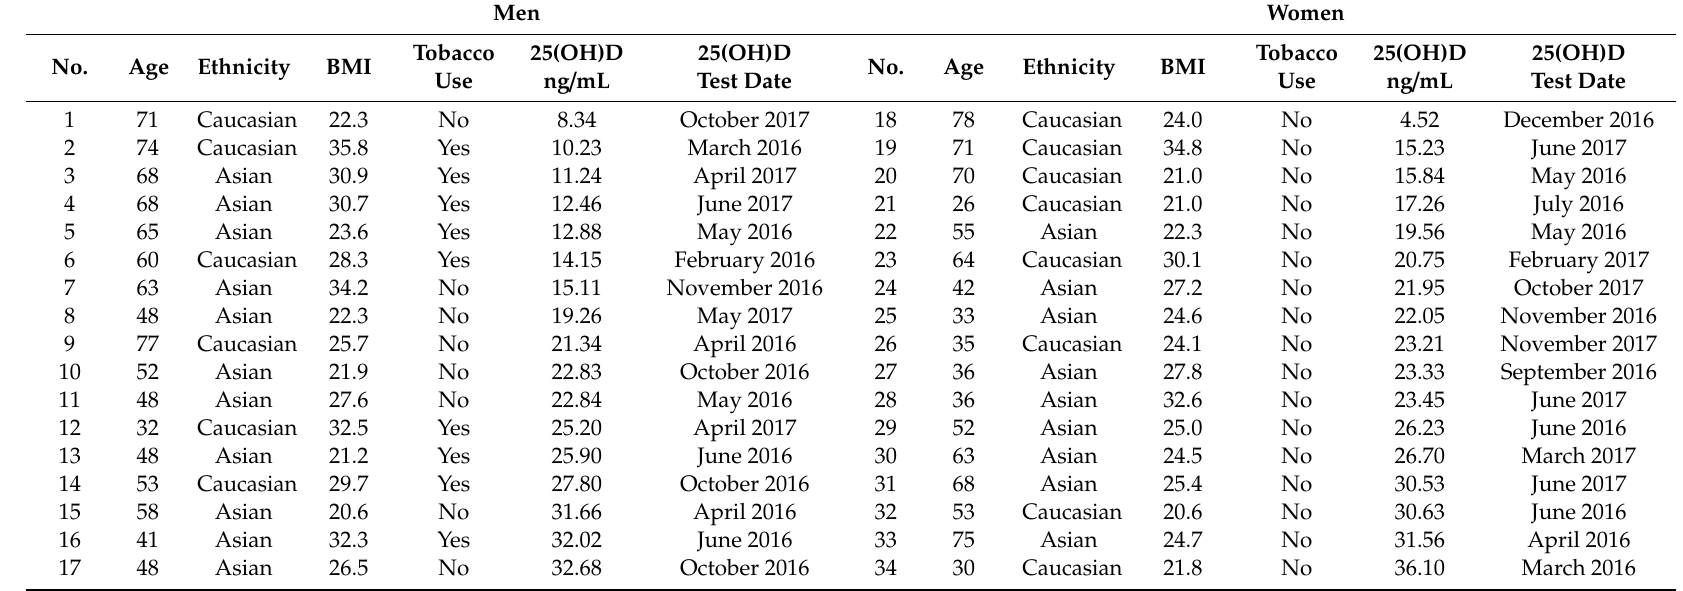
Table 2. Characteristics of healthy volunteers ( n =